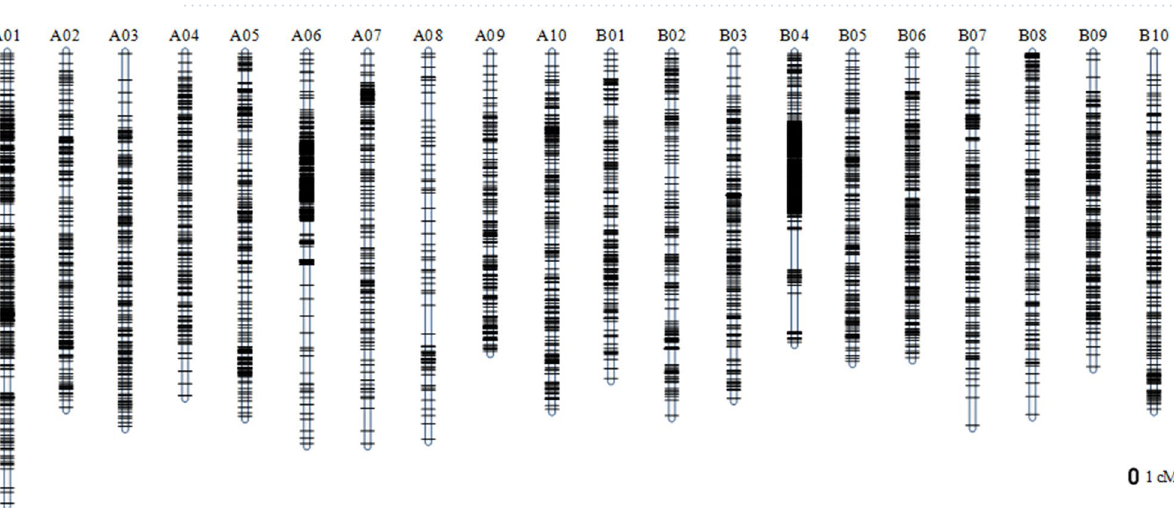
Figure 3. Genetic linkage map of RIL (F 6 ) population. The black bars on each chromosome represent SLAF markers on the genetic linkage